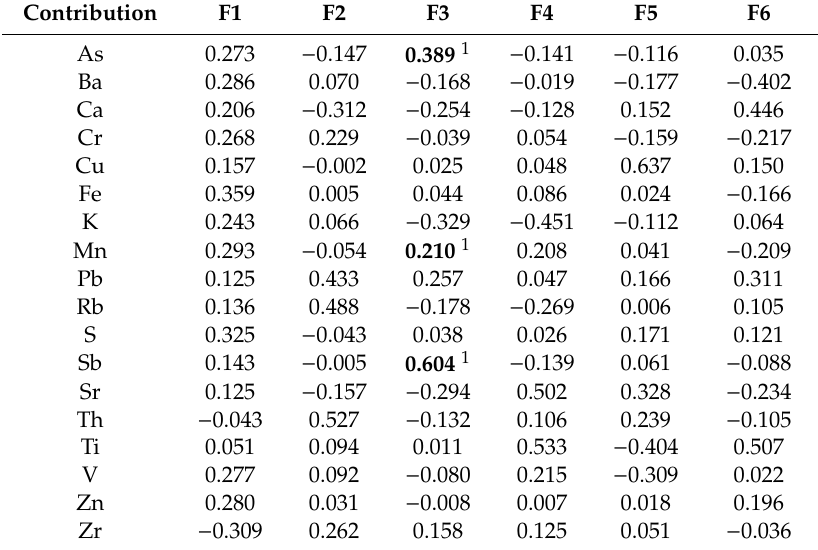
Table 2. Contribution of each element to the six main factors for B horizon observations, pXRF clr data. Contribution